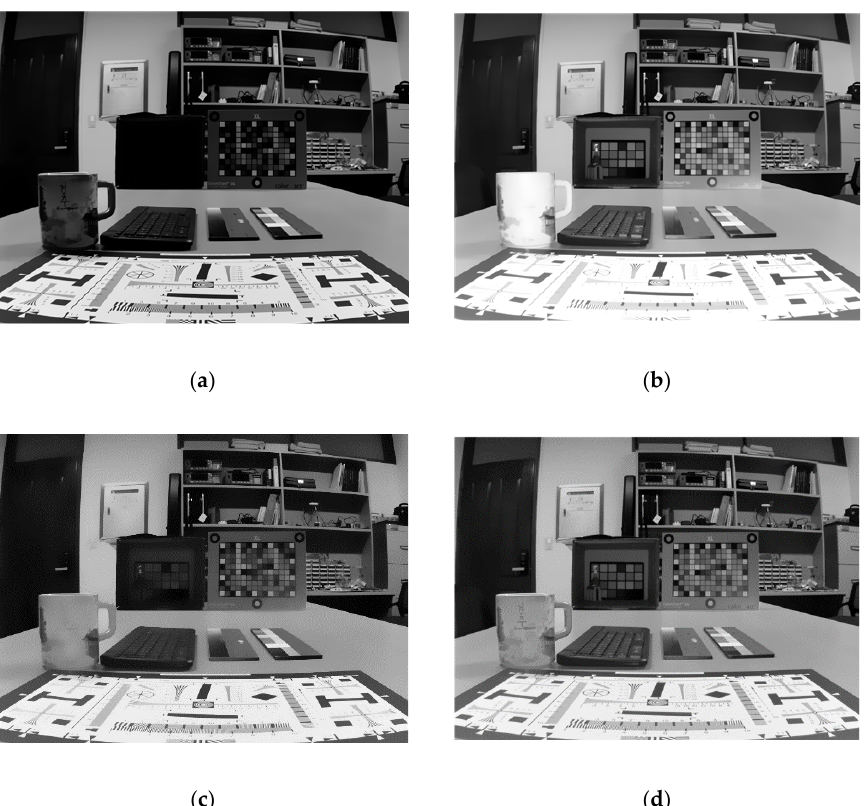
Figure 7. Base layer synthesis results: ( a ) visible-light image base layer, ( b ) near-infrared image base layer, ( c ) average synthesis result of luminance base layers, ( d ) proposed base layer synthesis result. Next, synthetic maps were added to reflect the characteristics of the nearest infrared images that appear differently between day and night, along with the joint bilateral filter. In the daytime visible-light image, a low-brightness area that inhibits visibility due to